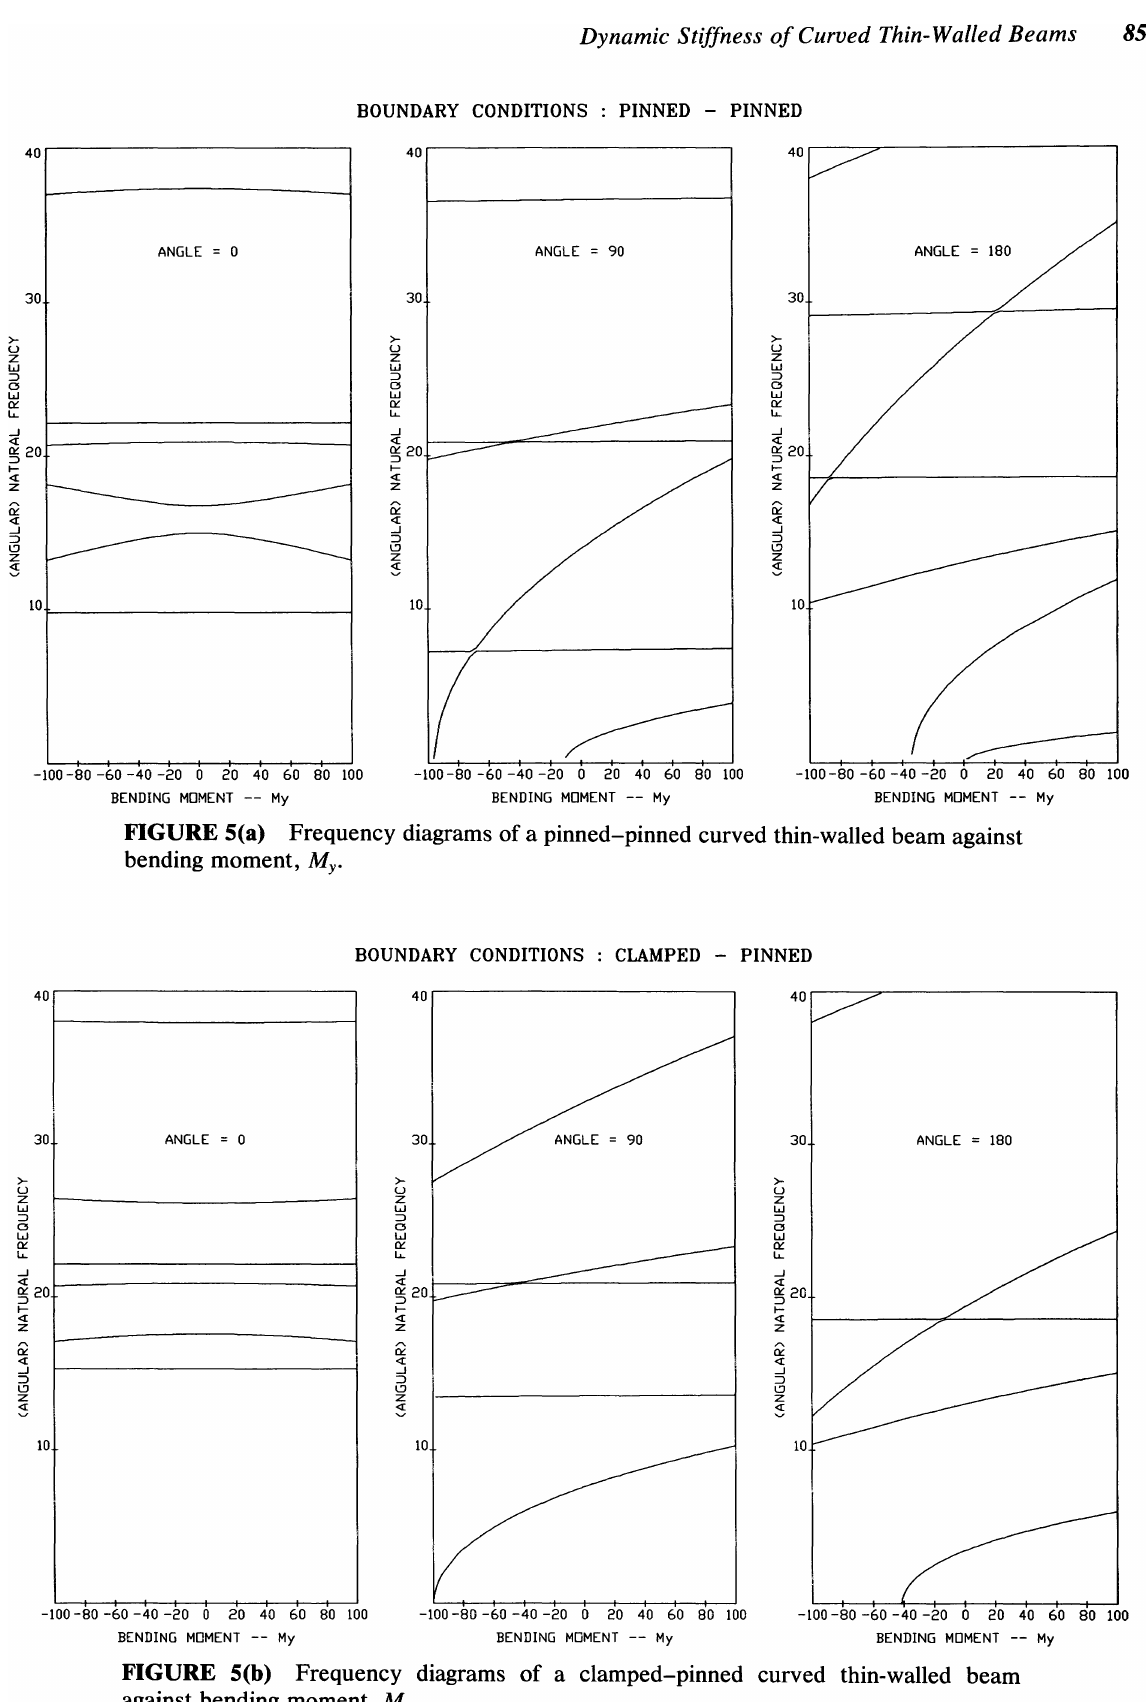
FIGURE 5(b) Frequency diagrams of a clamped-pinned curved thin-walled beam against bending moment,